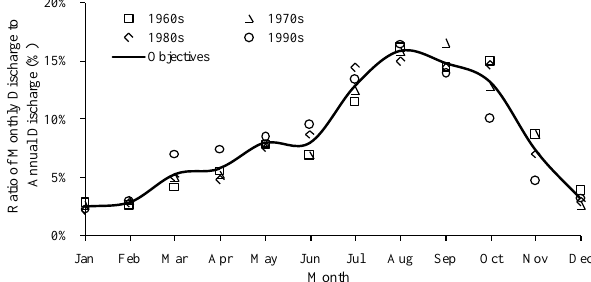
Fig. 2. Temporal variation objectives for environmental flows in the Yellow River estuary. Each point represents the average flow during the indicated